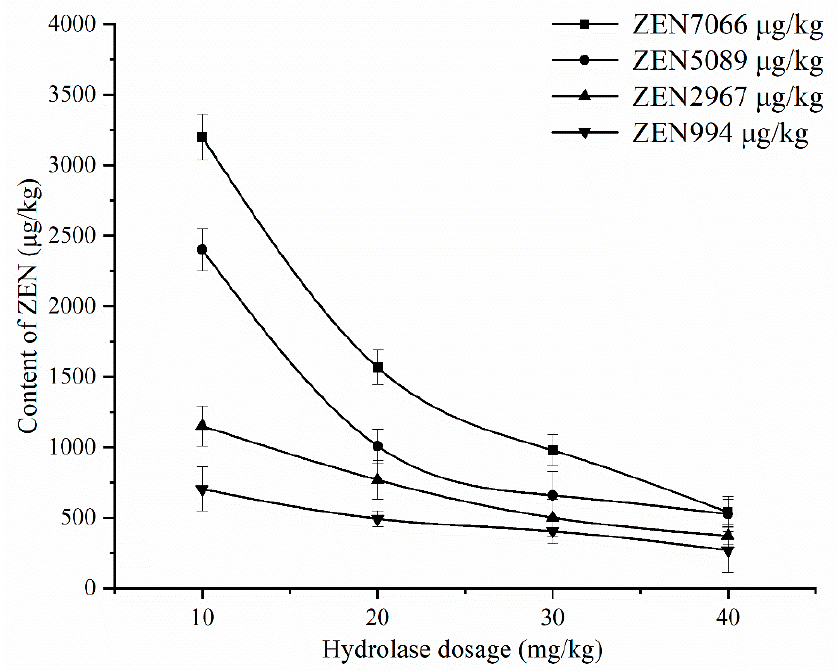
Figure 11. The effect of hydrolase dosage on the degradation of ZEN with different initial contents of ZEN in DCO.